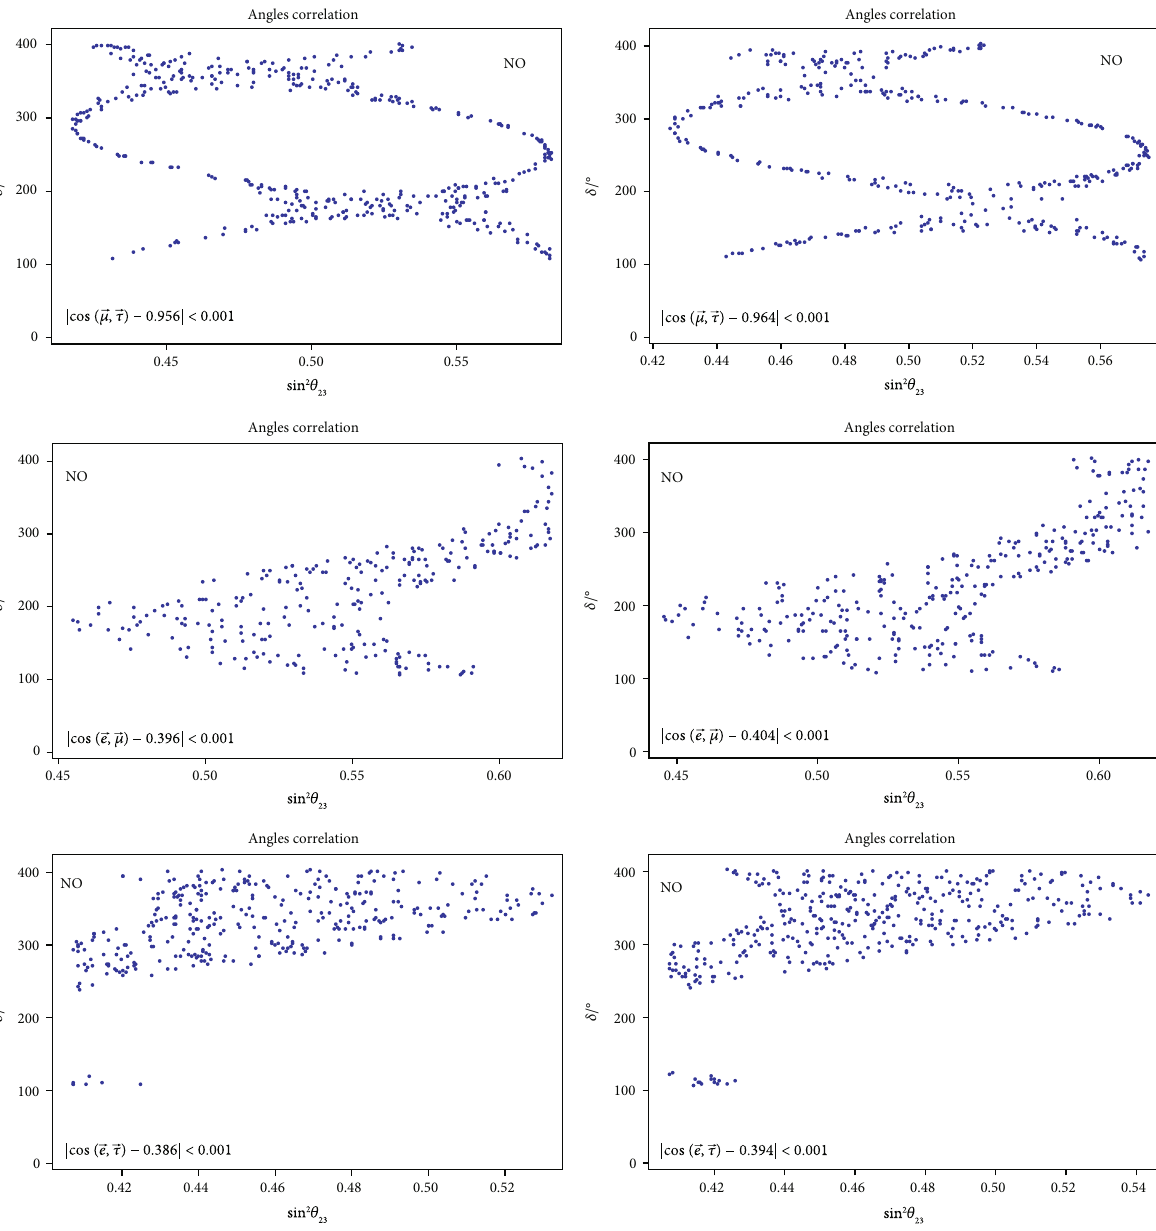
Figure 6: The correlations of sin 2 θ - δ constrained by the correlations of Equations (3) – (5) at the 3 σ level of the global fi t data [43]. 23 Table 3: Typical data points in the dense regions of Figure 2. Mass